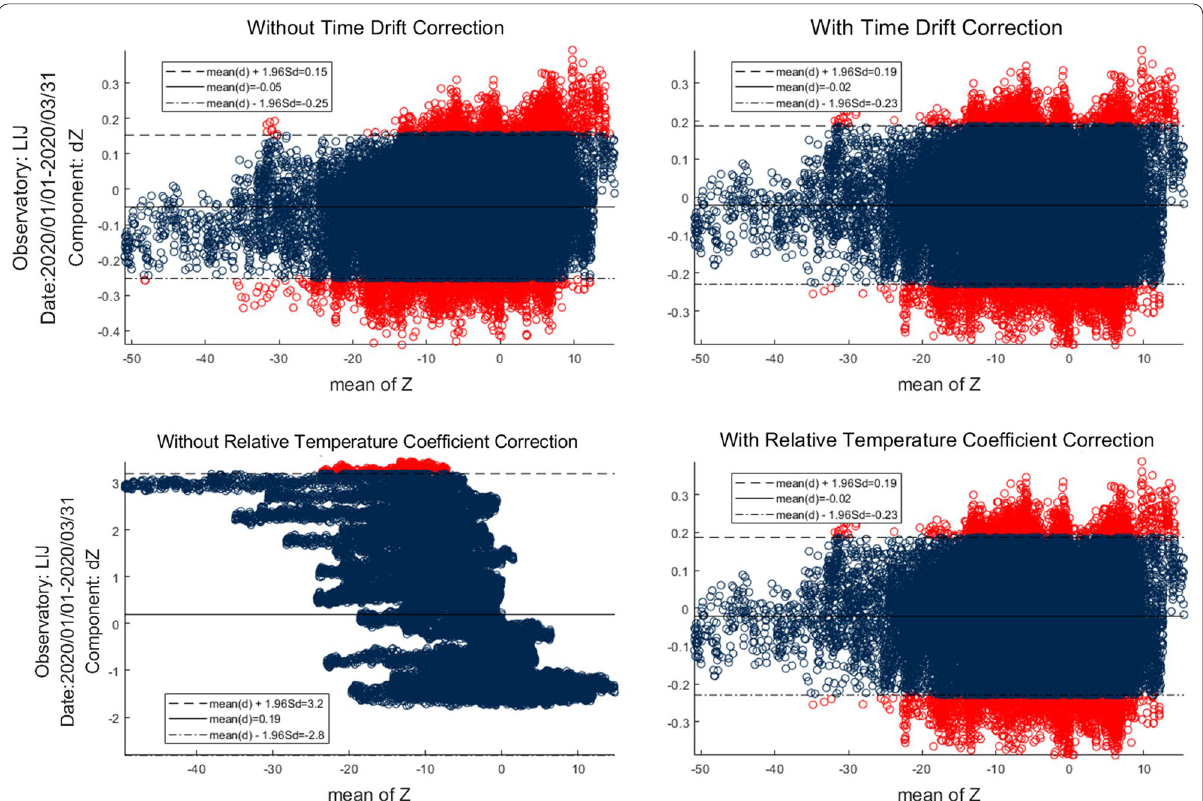
Fig. 12 Characteristics of the long-term time drift and the relative temperature coefficients in a B–A